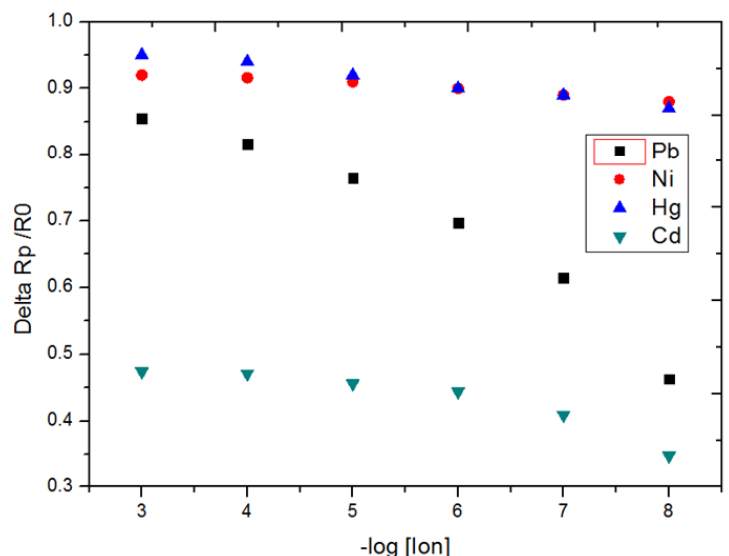
Figure 4. Relative variation of the polarization resistance of the P1 polymer-modified gold electrode interface as a function of −log concentration [Ion] (Pb 2+ , Ni 2+ , Hg 2+ and Cd 2+ ions). Table 3. Comparative study: responses of sensors based on polymer P1 for the di ff erent ions Pb 2 + , Hg 2 + , Ni 2 + and Cd 2 +